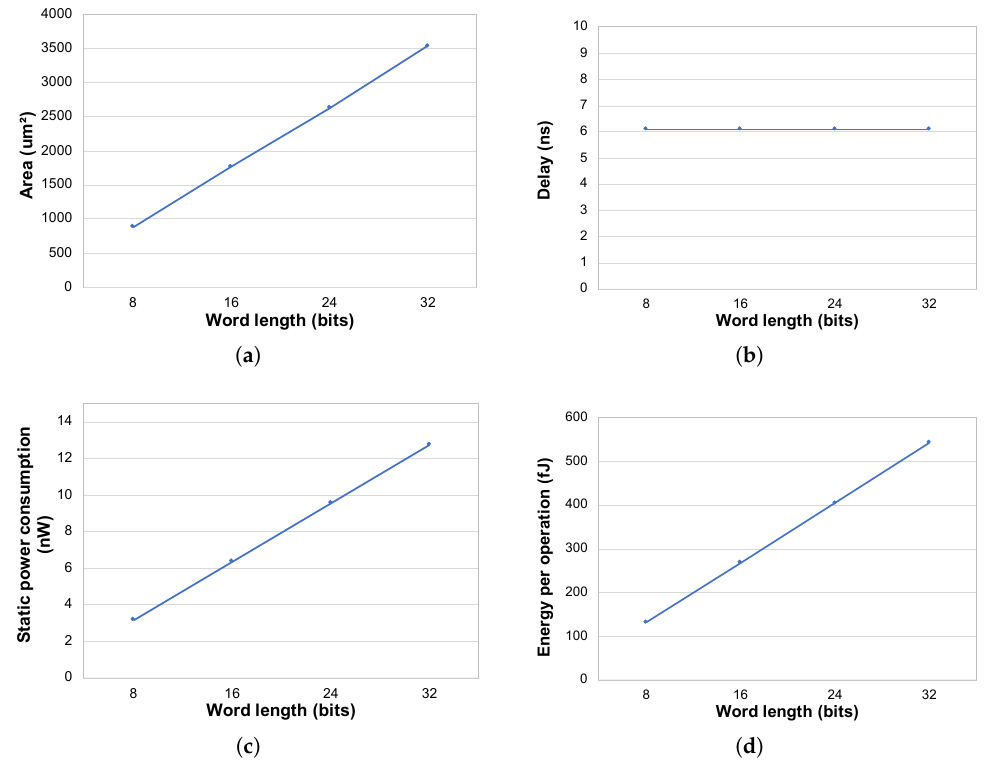
Figure 7. Register bank characterization in terms of data word length. ( a ) Area. ( b ) Delay. ( c ) Static power. ( d ) Energy per